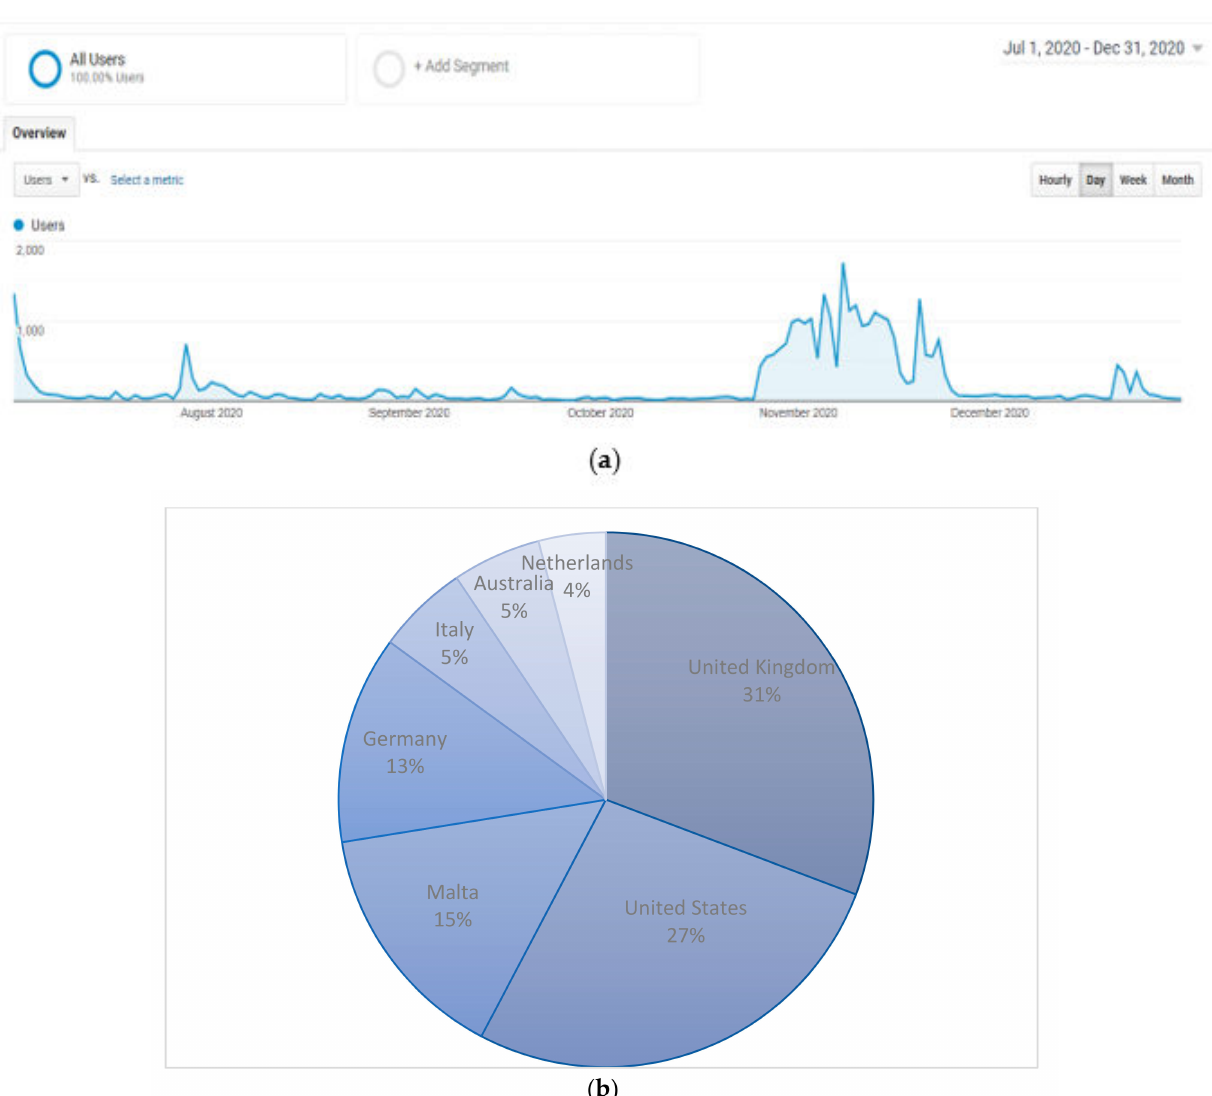
Figure 13. ( a ) Visitor number spikes in direct correlation to international publications and social media posts. ( b ) Visitor numbers reflecting the shift to an international audience (December 2020–February 2021)